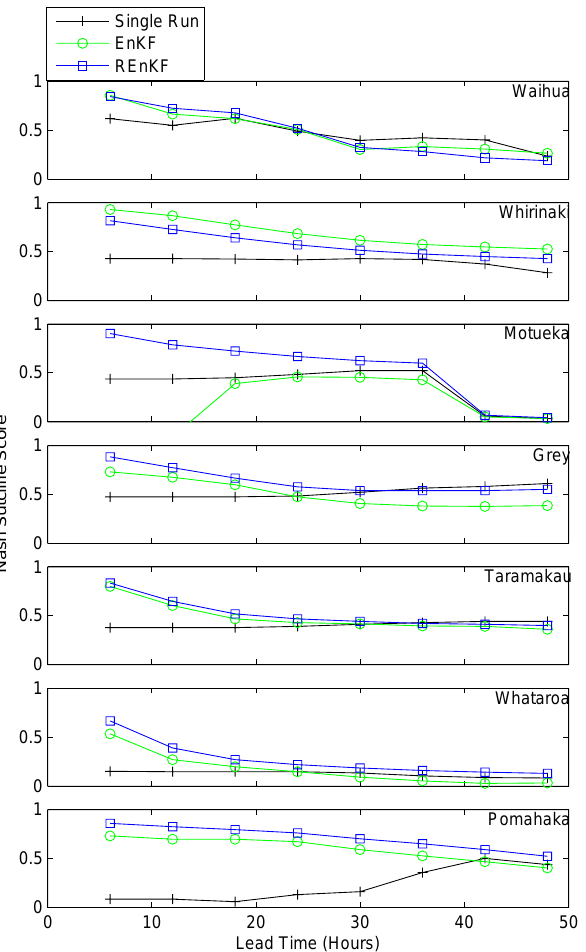
Fig. 8. Nash–Sutcliffe scores by catchment for single model run (no assimilation), EnKF and REnKF, for lead times 6–48h, calculated